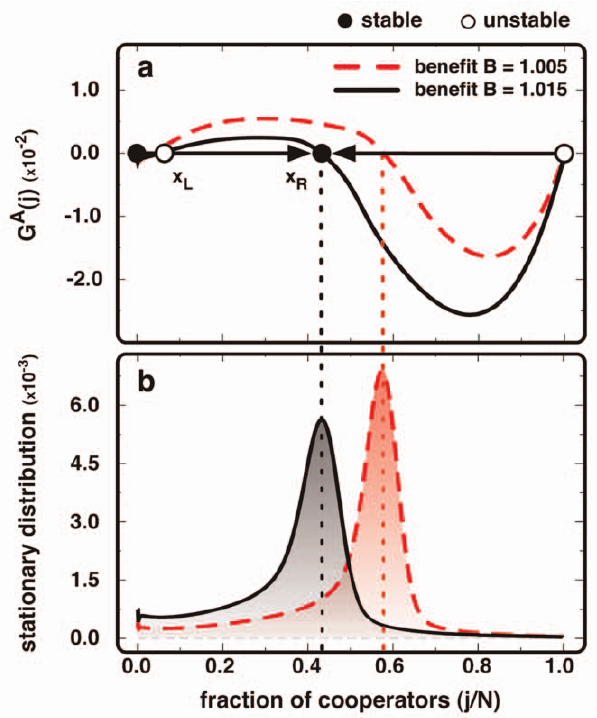
Figure 1. Time-independent AGoS. ( a ) We plot G A (j) for a population of players interacting via a PD in a homogeneous random network, for two values of the benefit B . Globally, G A (j) indicates that the population evolves towards a co-existence scenario. ( b ) Stationary distributions showing the pervasiveness of each fraction j/N in time. In line with the AGoS in a ), the population spends most of the time in the vicinity of the stable-like root x R of G A (j) . When j/N < 0 , C s become disadvantageous, giving rise to an unstable-like root x L of G A (j) which, however, plays a minor role as shown ( N =10 3 , , k . =4 and b = 1.0 ). Homogeneous random networks were obtained by repeatedly swap- ping the ends of pairs of randomly chosen links of a regular lattice [54].